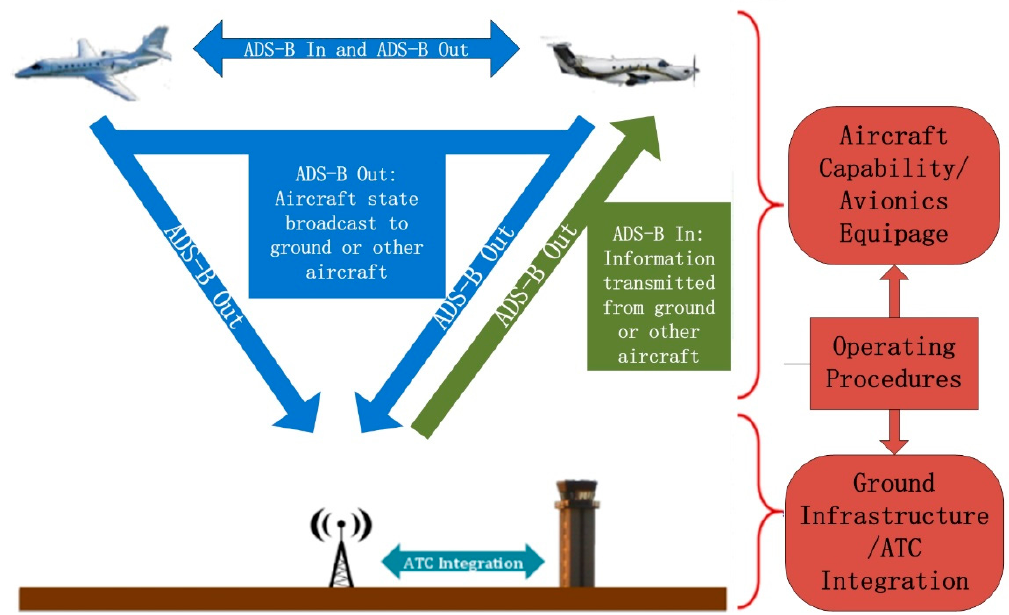
Figure 1. Automatic Dependent Surveillance–Broadcast (ADS-B) data transmission.